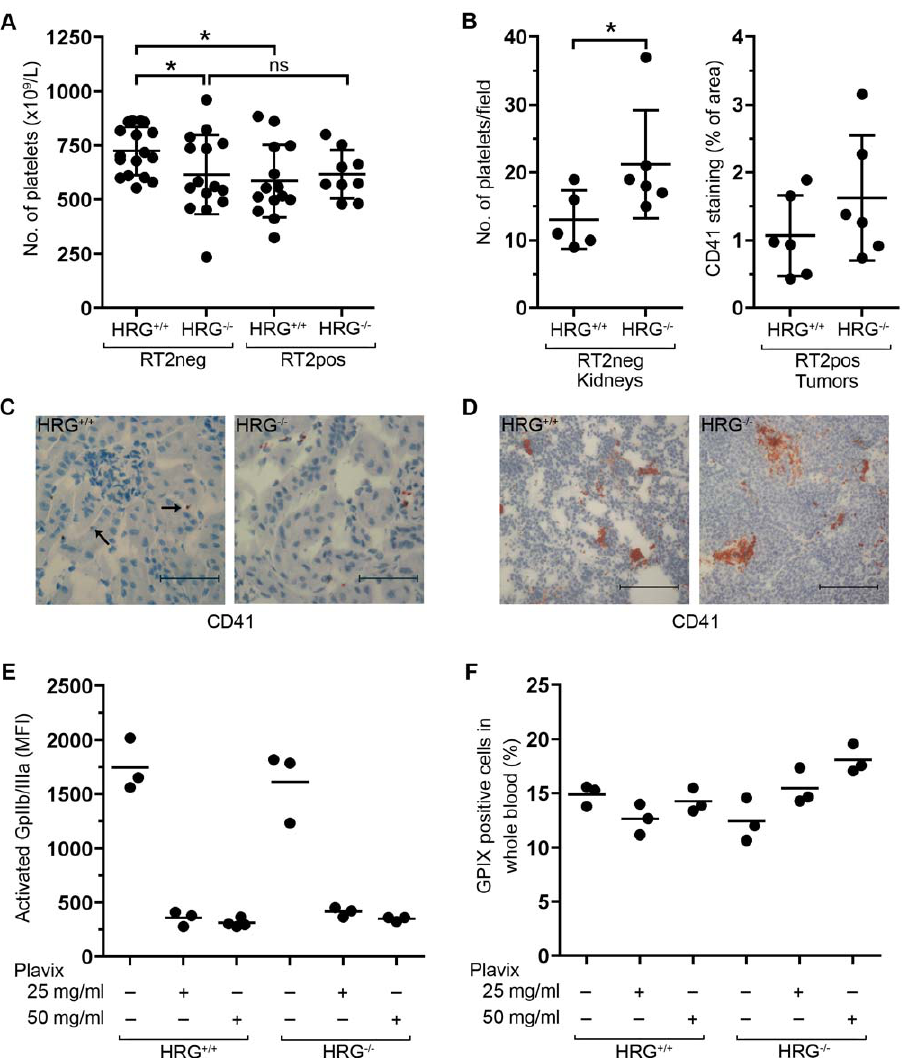
Figure 5. HRG regulates platelet levels in the circulation. (A) Platelet numbers in whole blood from RT2 positive or negative mice with different HRG genotypes (HRG + / + or HRG 2 / 2 ). (B) Left panel; Quantification of the number of platelets/field in kidney tissue from healthy (RT2- negative) HRG + / + or HRG 2 / 2 mice. Right panel; Quantification of the area percentage stained positive for the platelet marker CD41 in tumor tissue from RT2-positive HRG + / + and HRG 2 / 2 mice. (C, D) Immunohistochemical staining directed against CD41 was performed on kidney from RT2-negative mice (C) and tumor tissue from RT2-positive mice (D) from both genotypes. Arrows indicate platelets. (E) HRG + / + and HRG 2 / 2 mice were treated with Plavix (25 mg/ml or 50 mg/ml in drinking water) for three days. Platelet activation in whole blood was measured after stimulation with 10 m M ADP by flow cytometric analysis of the activated fibrinogen receptor (GPIIb/IIIa). (D) Platelet levels after Plavix treatment were measured by flow cytometric analysis in whole blood and are presented as the percentage of GPIX positive cells. Statistical analyses were performed with a two-tailed Mann- Whitney test, vertical bars represent standard deviation, * p # 0.05, ns=non significant. Scale bars represent 50 m m in C and 100 m m in D.